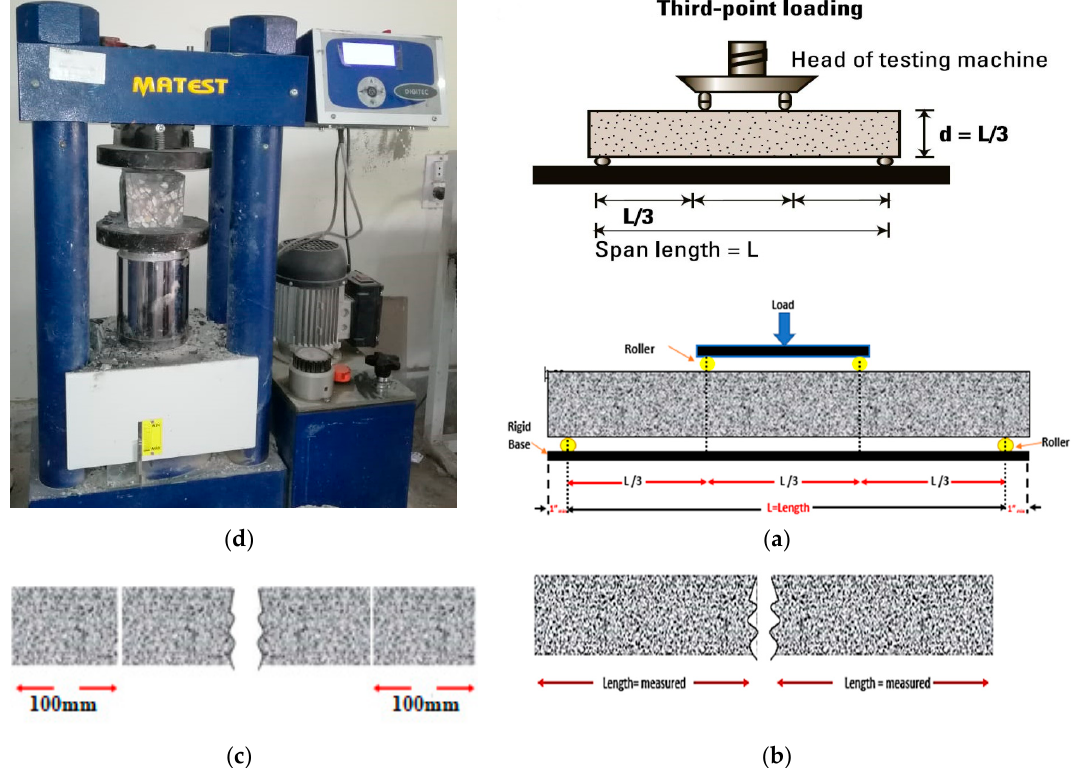
Figure 3. ( a ) Flexural strength test mechanism, ( b ) broken beam diagram after test, ( c ) cutting